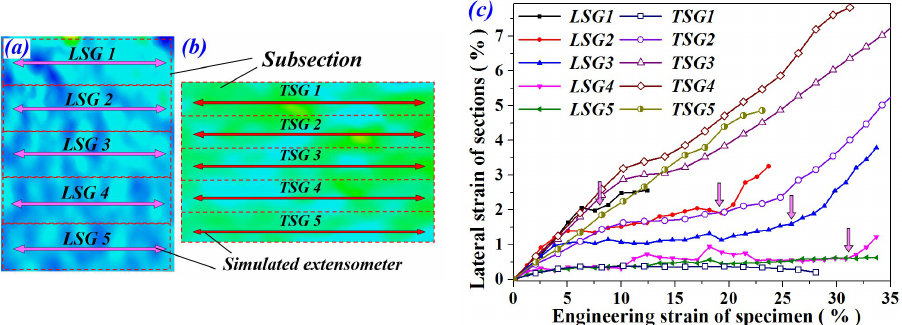
Figure 12. ( a , b ) Schematic diagram of simulated extensometers and ( c ) lateral strain curves of LC and TC specimens.